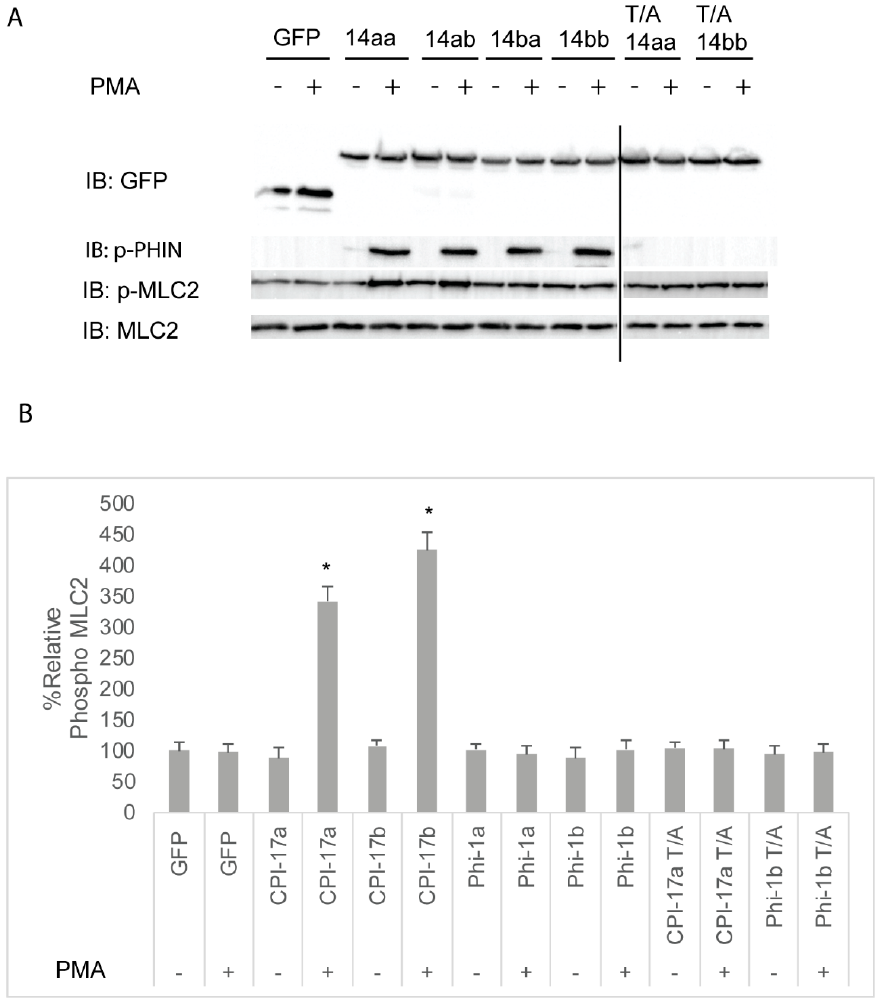
for 3 h. In the absence of PMA, phosphorylation of Cpi-17 or Phi-1 was barely detectible, but increased considerably after PMA treatment (Figure 7A). In the absence of PMA, none of the transfections resulted in any appreciable increase in Mlc2 phosphorylation (Figure 7B). In contrast, in the presence of PMA, Cpi-17a and Cpi-17b significantly increased Mlc2 phosphorylation. Importantly, if the conserved phosphorylation sites are mutated to alanine, Cpi-17a cannot be phosphorylated, and loses its ability to increase Mlc2 phosphorylation (Figure 7A and B).